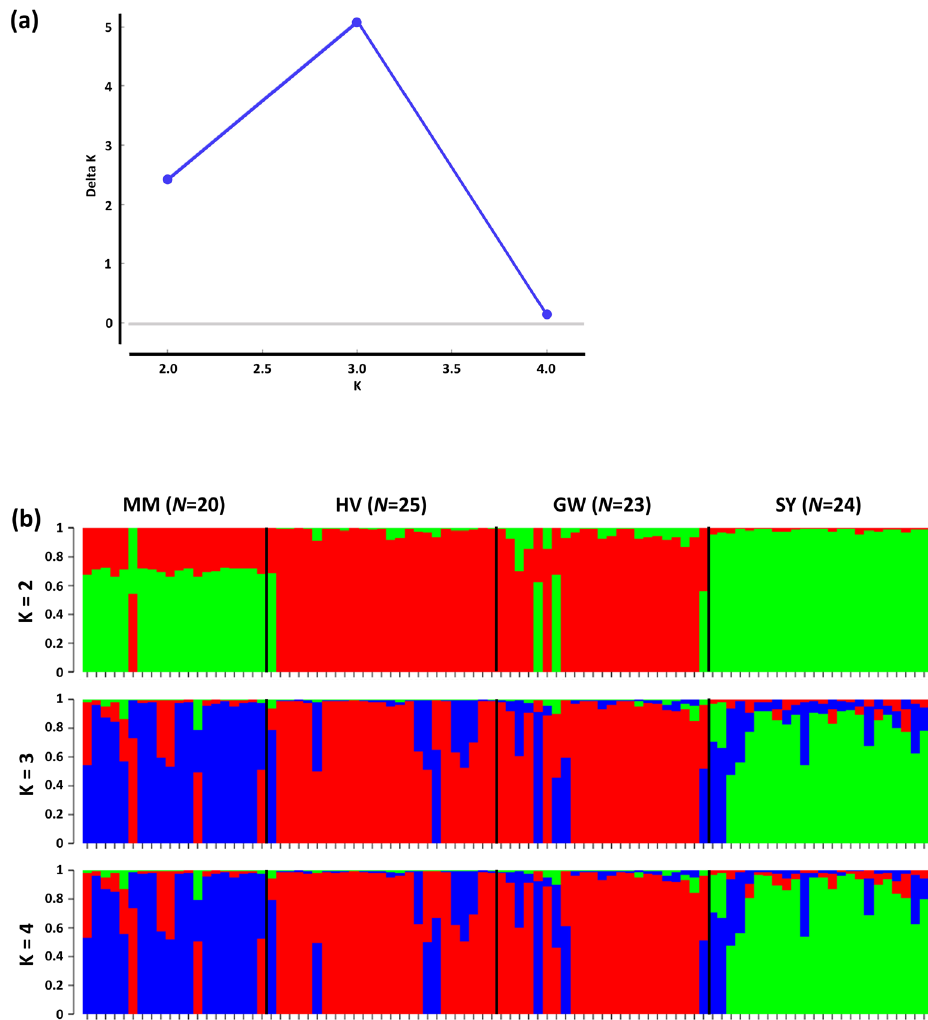
Figure 3. Genetic composition of Chamaecyparis formosensis . ( a ) The scatter plots of Delta K. ( b ) The 2, 3 and 4 clusters obtained from STRU CTU RE analyses.